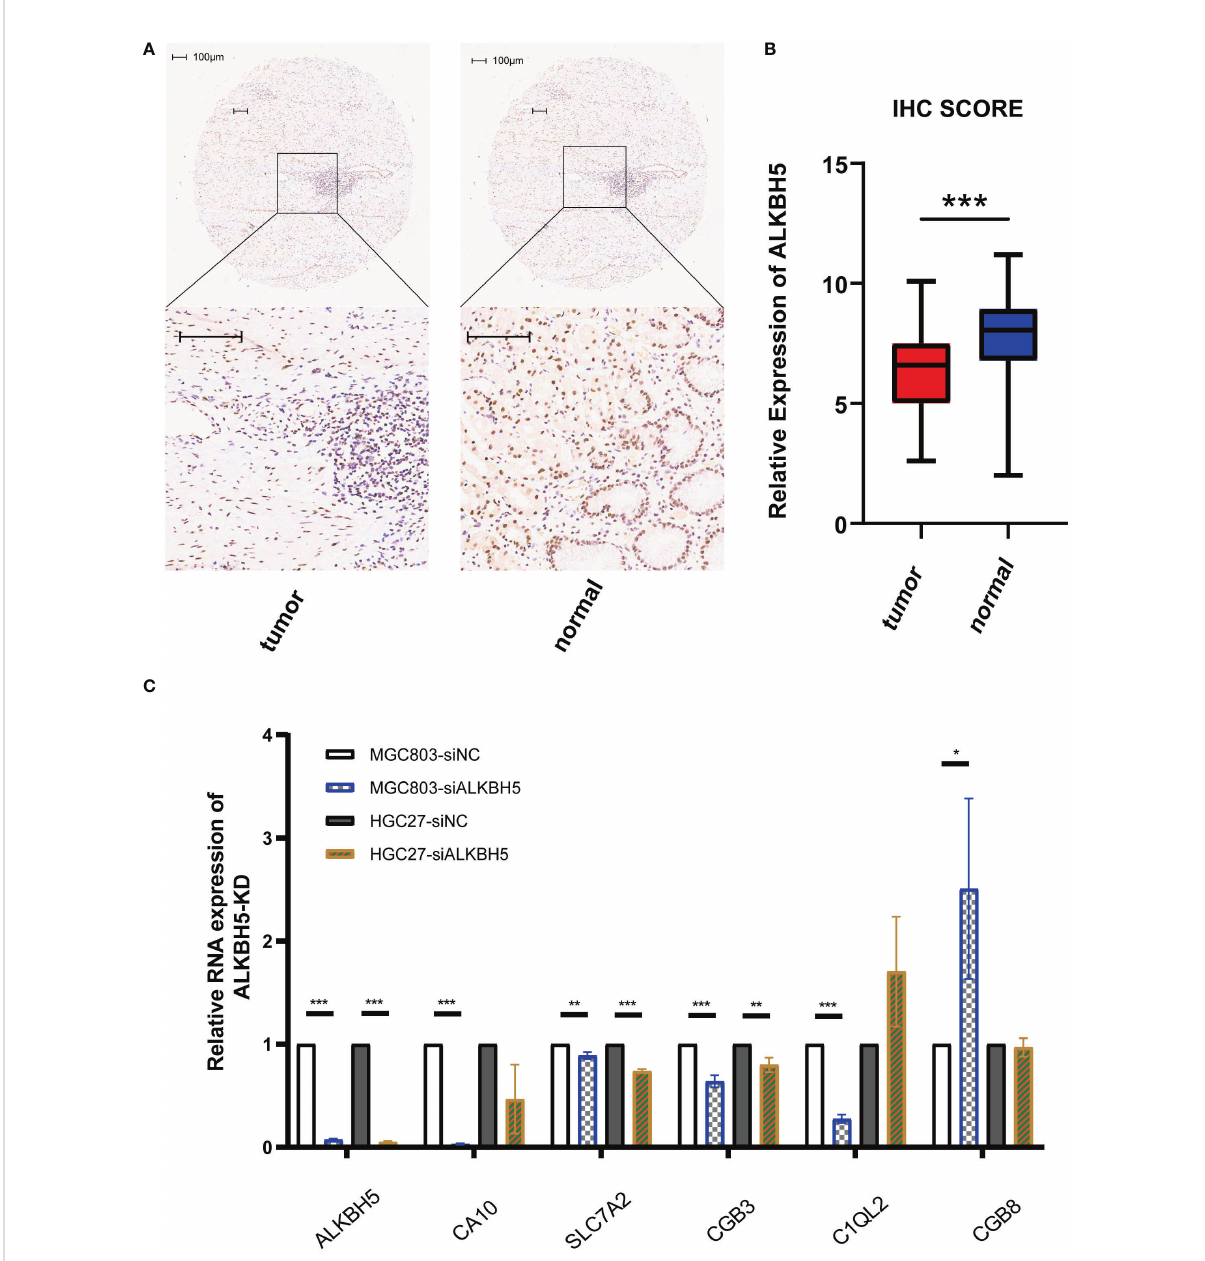
FIGURE 8 Validation of lowly expressed ALKBH5 in GC tissues and related genes ’ mRNA-level response to ALKBH5 knockdown. (A) Representative images of IHC for stained ALKBH5 in GC tumor tissues and adjacent normal tissues. (B) Box plot showing the IHC scores of the tumor group and normal group. (C) Relative RNA expression levels of related genes when ALKBH5 was knocked down. Scale bar, 100 m m. *P < 0.05, **P < 0.01, and ***P <